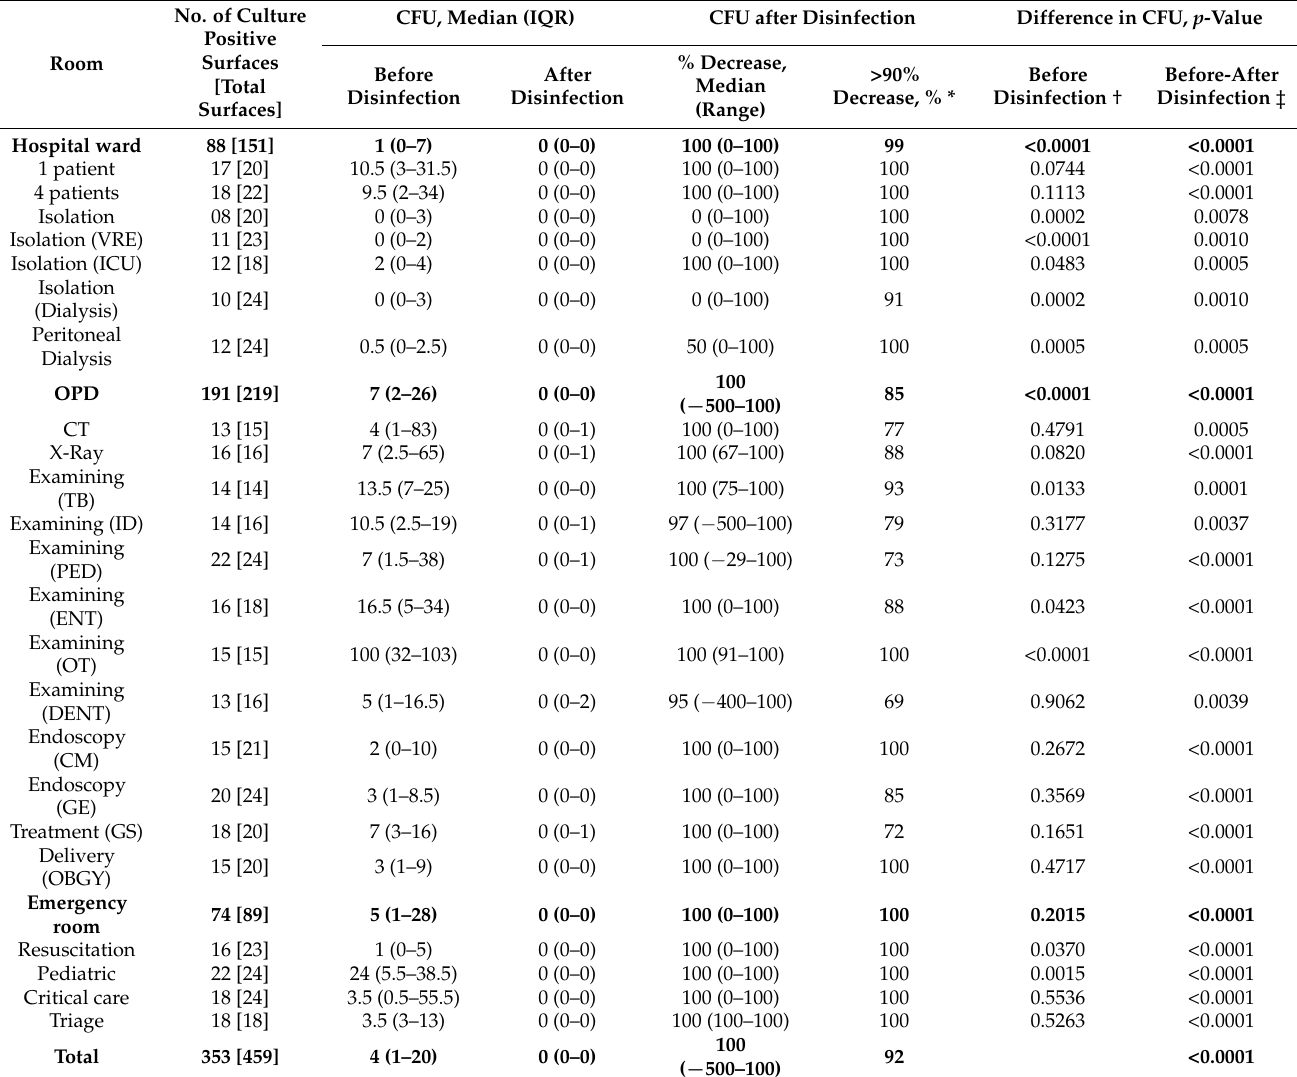
Table 2. CFU values of gram-positive bacteria from surfaces in 23 rooms (three types) before and after disinfection with plasma-treated hydrogen peroxide mist